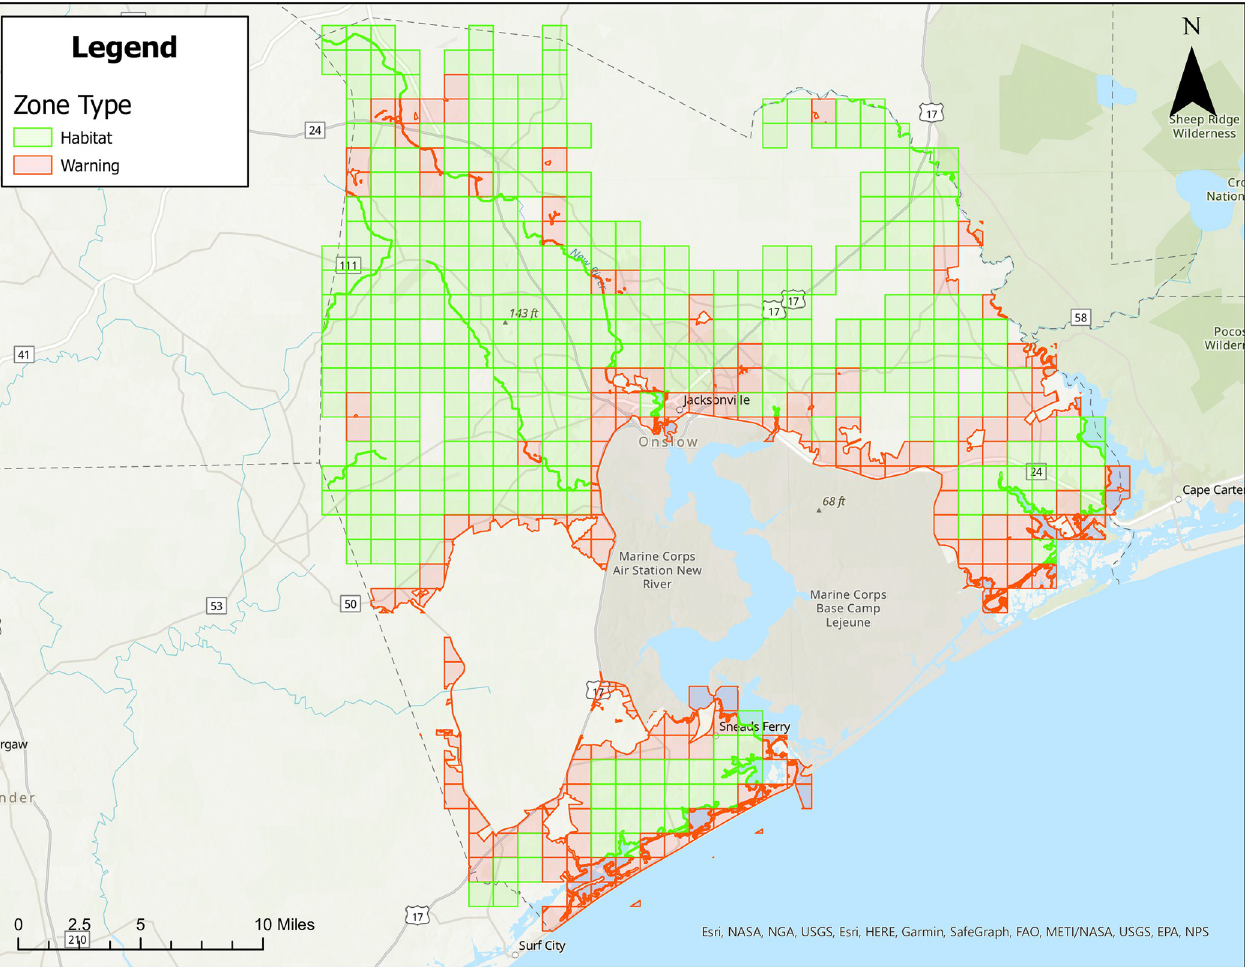
Fig 3. Areas in Onslow County, North Carolina for treatment consideration classified as approved (green) or warning (red). Maps do not consider human population density. Source files for maps (NC OneMap: Address, county, rivers, water bodies provided as S2 and S3 Files. Written release agreements